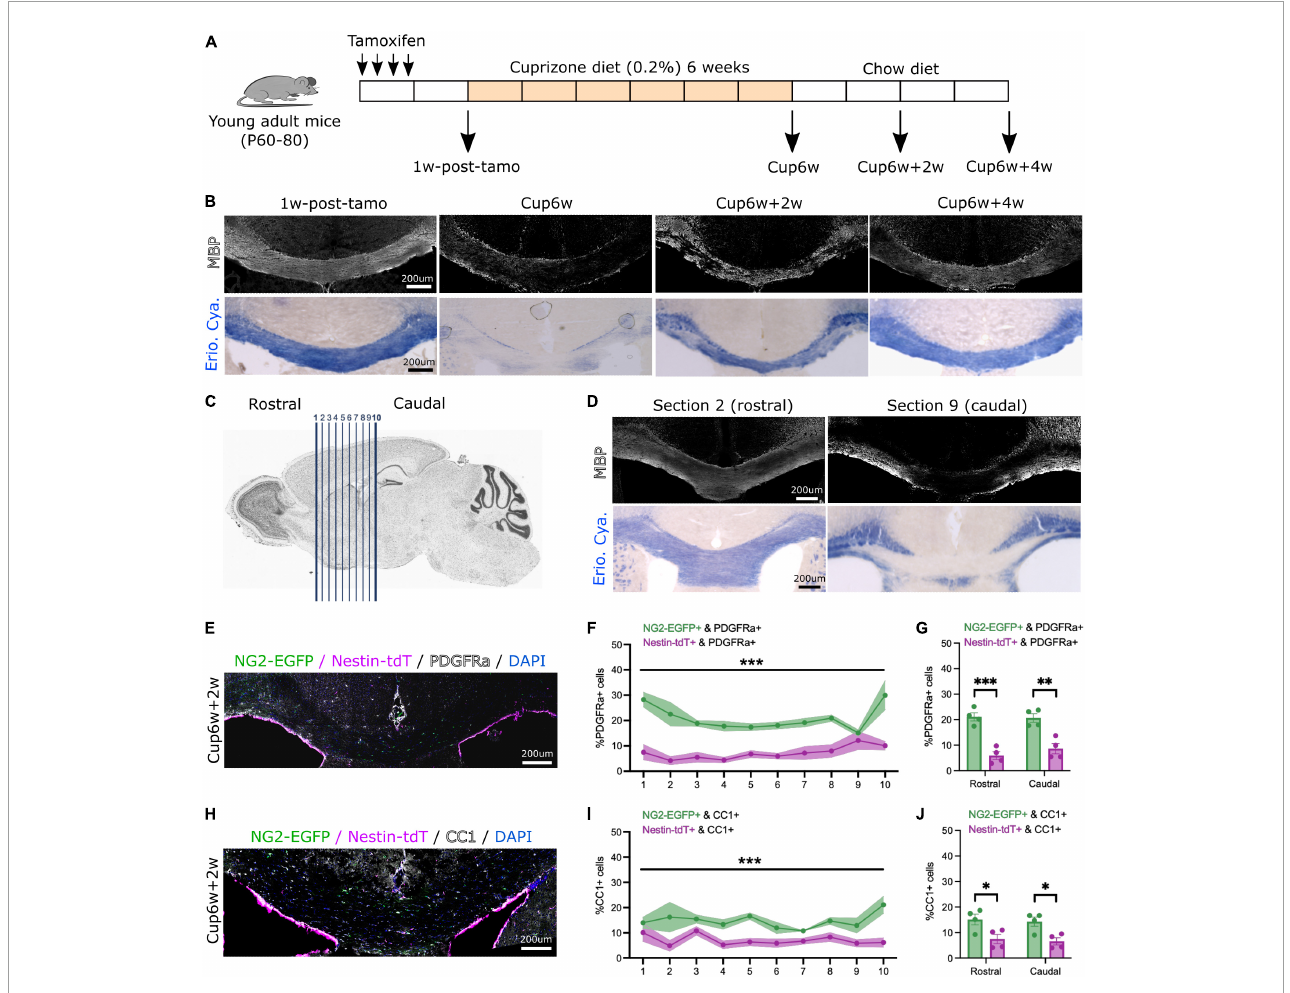
FIGURE1 Both neural stem cell-derived oligodendrocytes (OLs) and parenchymal oligodendrocyte progenitor cells (pOPCs) contribute to corpus callosum remyelination. (A) Schematic of the experimental design used for our inducible dual reporter NG2-EGFP;Nestin-tdT line and inducible conditional knock-out Myrf-cKO;Nestin-tdT line. (B) Representative images of NG2-EGFP;Nestin-tdT coronal brain section immunostained for MBP (in white, top) or stained with Eriochrome Cyanine (Erio. Cya., in blue, bottom), before (1w-post-tamo), after a 6-week cuprizone diet (Cup6w) and after recovery (Cup6w + 2w and Cup6w + 4w). (C) Schematic showing serial coronal sectioning of a mouse brain, from rostral (section 1) to caudal (section 10). (D) Coronal brain images of section 2 (rostral) and section 9 (caudal) of the same NG2-EGFP;Nestin-tdT animal, immunostained for MBP (in white, top) or stained with Eriochrome Cyanine (Erio. Cya., in blue, bottom), after a 6-week cuprizone diet. (E) Representative image of NG2-EGFP;Nestin-tdT coronal brain section immunostained for PDGFRa (in white) after 2-week recovery (Cup6w + 2w). (F) Quantification of the percentages of PDGFRa+ cells that were also NG2-EGFP+ or Nestin-tdT+ for all rostral to caudal CC sections ( n = 4, lines and shading represent mean ± sem, ∗∗∗ p < 0.001, Two-way ANOVA). (G) Average percentages of PDGFRa+ cells that were also NG2-EGFP+ or Nestin-tdT+ for rostral (sections 1–5) and caudal (sections 6–10) sections ( n = 4, error bars = sem, ∗∗∗ p < 0.001, ∗∗ p < 0.01, Student’s t -test). (H) Representative image of NG2-EGFP;Nestin-tdT coronal brain section immunostained for CC1 (in white) after 2-week recovery (Cup6w + 2w). (I) Quantification of the percentages of CC1+ cells that were also NG2-EGFP+ or Nestin-tdT+ for all rostral to caudal CC sections ( n = 4, lines and shading represent mean ± sem, ∗∗∗ p < 0.001, Two-way ANOVA). (J) Average percentages of CC1+ cells that were also NG2-EGFP+ or Nestin-tdT+ for rostral (sections 1–5) and caudal (sections 6–10) sections ( n = 4, error bars = sem, ∗ p < 0.05, Student’s t